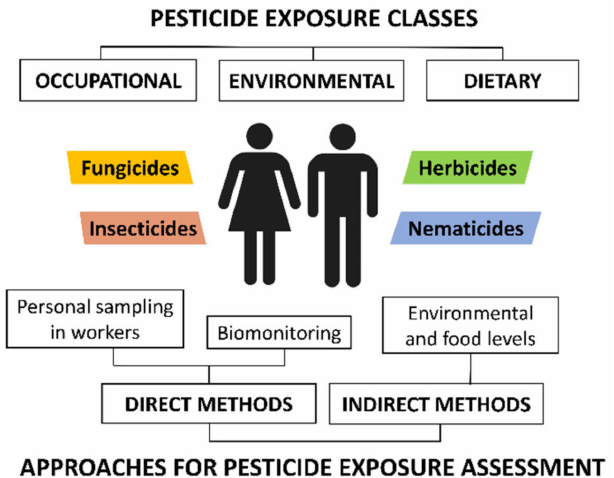
Figure 1. Classification of pesticide exposure routes and methodologies for pesticide exposure